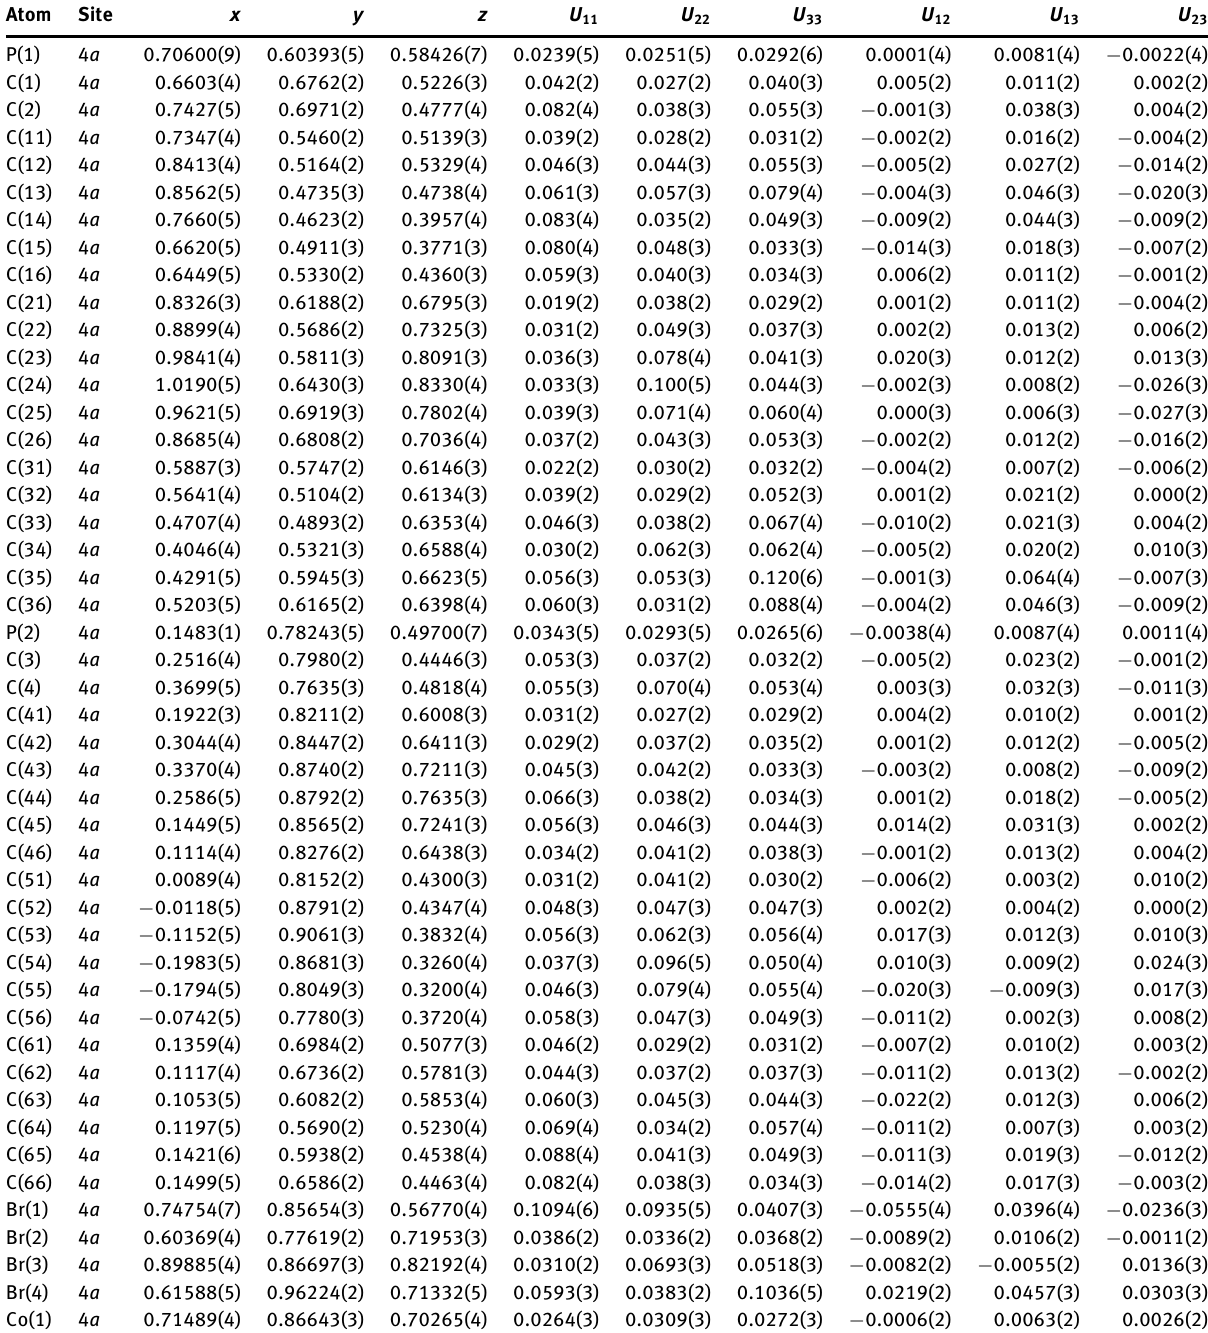
Table 3: Atomic coordinates and displacement parameters (in Å 2